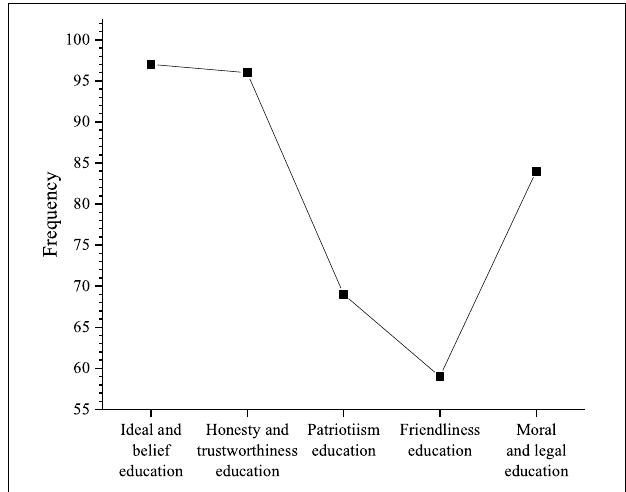
FIGURE 10 | Contents of entrepreneurship